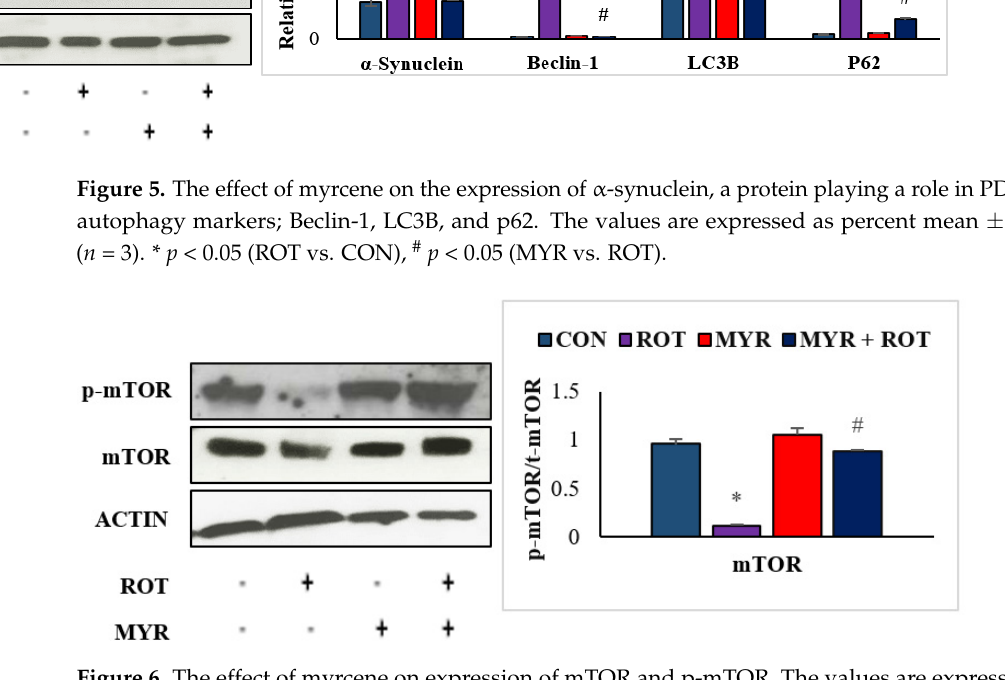
Figure 6. The effect of myrcene on expression of mTOR and p-mTOR. The values are expressed as percent mean ± SEM ( n = 3). * p < 0.05 (ROT vs. CON), # p < 0.05 (MYR vs. ROT).